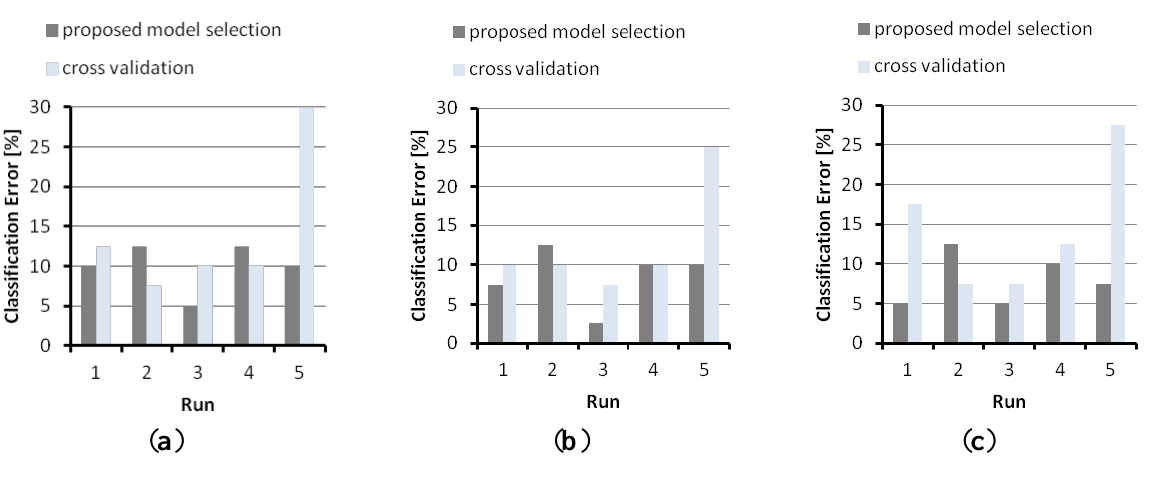
Figure 8. A comparison between the generalization performance obtained by applying the model selection of Algorithm 1 and conventional cross-validation. The graphs refer